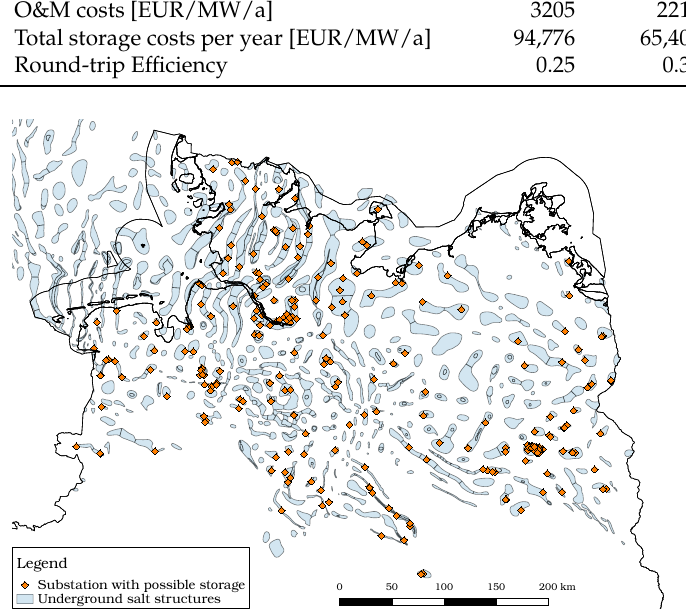
Figure 1. Salt formations in northern Germany (light blue) and substations located on top of these (orange diamonds) as possible sites for underground hydrogen storage units with connection to the power grid. Source for data on salt formations: Salzstrukturen c (cid:13) BGR, Hannover,